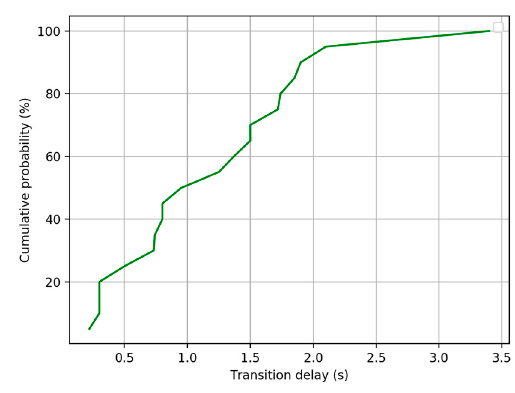
Figure 12. The cumulative probability of transition delay.